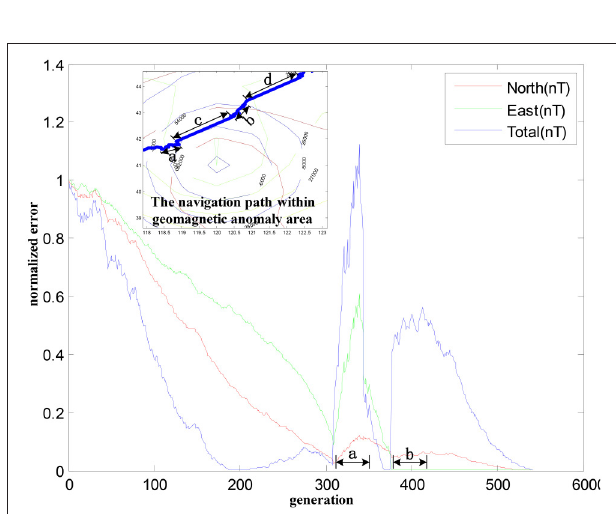
FIGURE 8 | The geomagnetic components convergence within the geomagnetic anomalies.